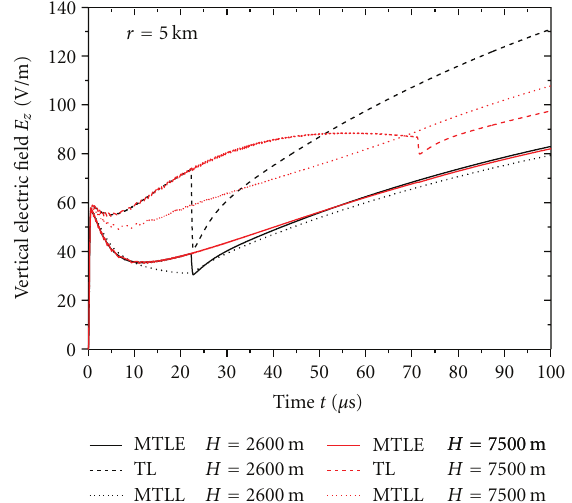
Figure 7: Vertical electric field at 50m from the channel base for MSS FST, three di ff erent models and two channel heights ( H = 2600 m and 7500